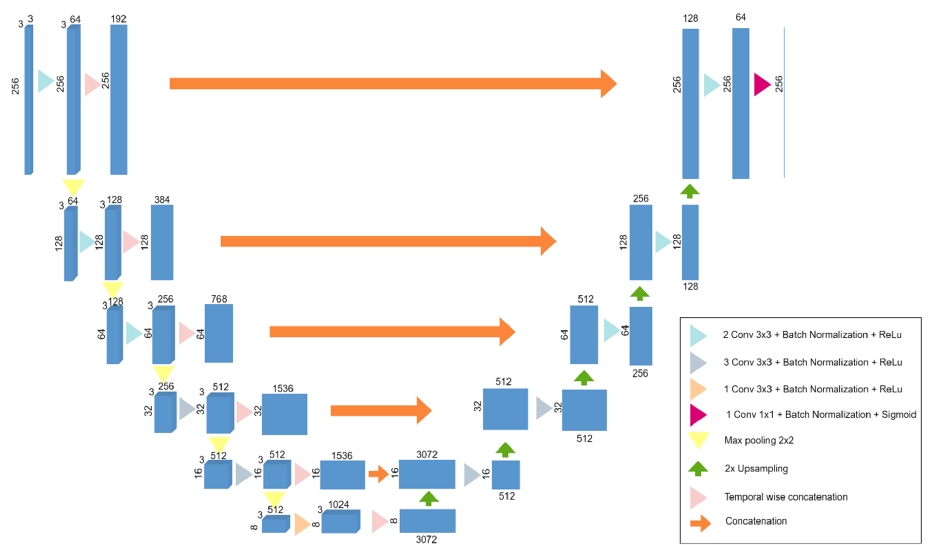
Figure 4. The proposed architecture to perform multi-temporal learning.